Question: In one sentence, what is this figure communicating?
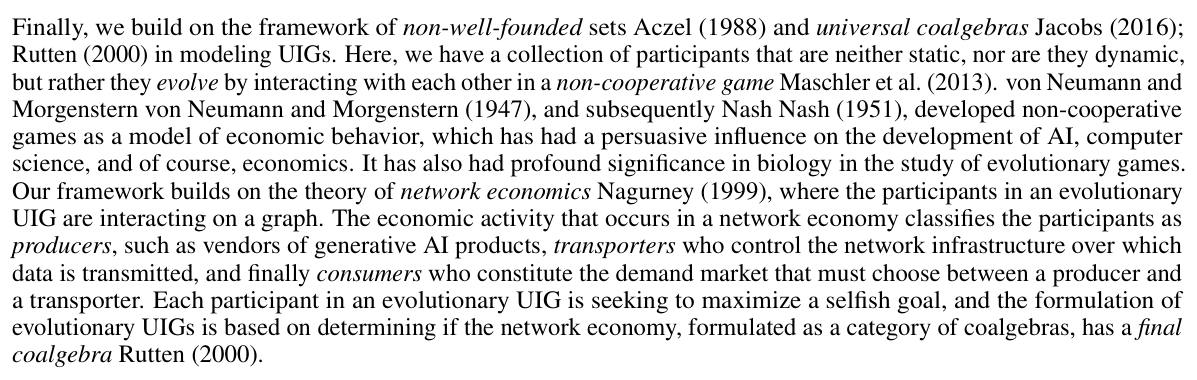
Answer: compares the basic notions in set theory vs. category theory. Figure 8 illustrates a simple category of 3 objects: A, B, and C that interact through the morphisms f : A →B, g : B →C, and h : A →C. Categories involve a fundamental notion of composition: the morphism h : A →C can be defined as the composition g ◦f of the morphisms from f and g. What the objects and morphisms represent is arbitrary, and like the canonical directed graph model, this abstractness gives category theory – like graph theory – a universal quality in terms of applicability to a wide range of problems. While categories and graphs and intimately related, in a category, there is no assumption of finiteness in terms of the cardinality of objects or morphisms. A category is defined to be small or locally small if there is a set’s